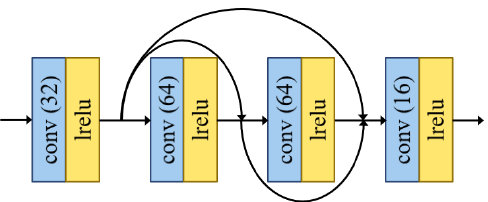
Figure 2. The network architecture of the preliminary/intermediate fusion module.